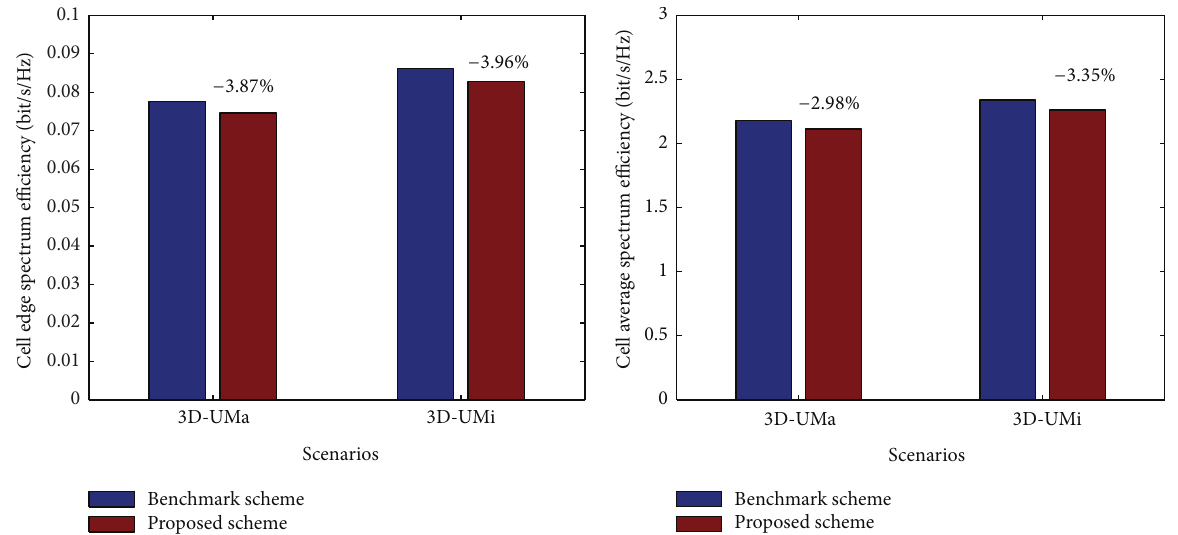
Figure 7: The system-level simulation results of the proposed feedback scheme.